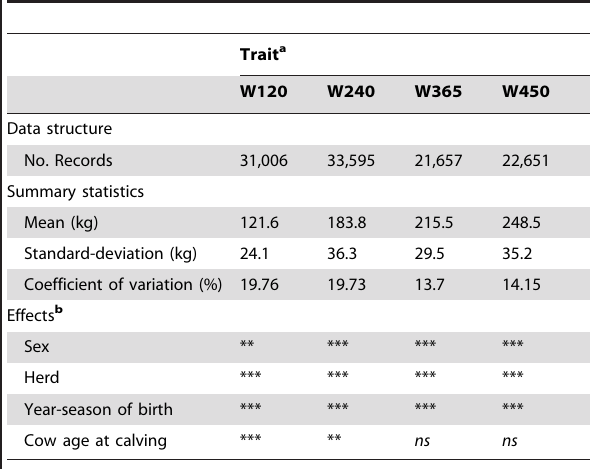
Table 1. Number of records in the data, summary of statistics and significance of the source of